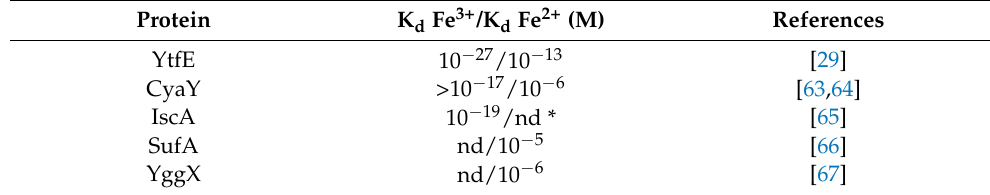
Table 4. Dissociation constants of iron donors proposed for E. coli and YggX of S. enterica .